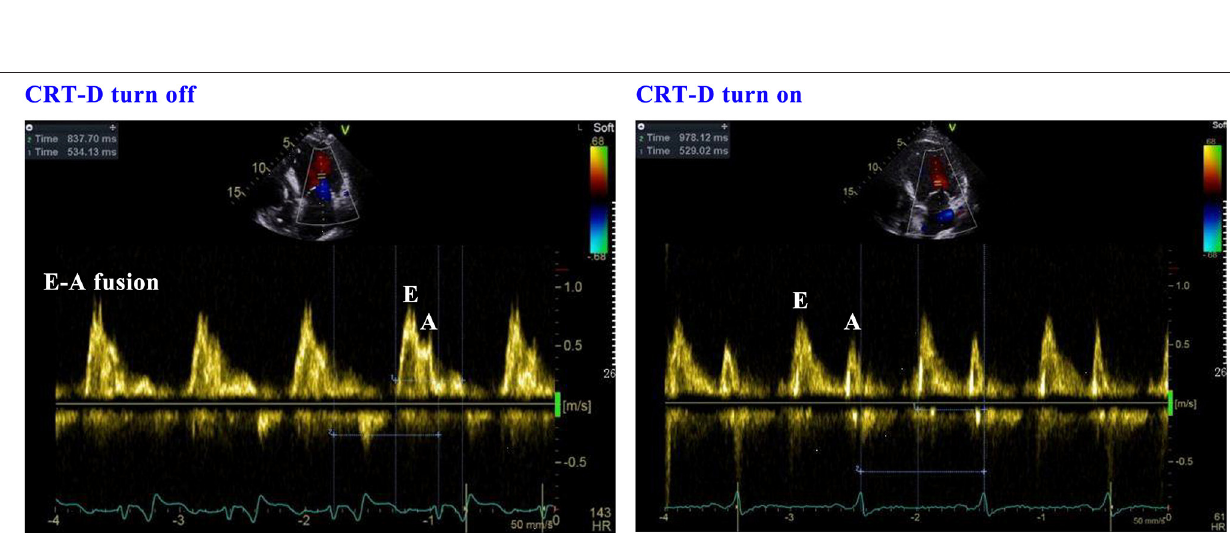
FIGURE 4 | Radiologic images of the cardiac resynchronization therapy system showing lead positioning. LV, left ventricular; RV, right ventricular.